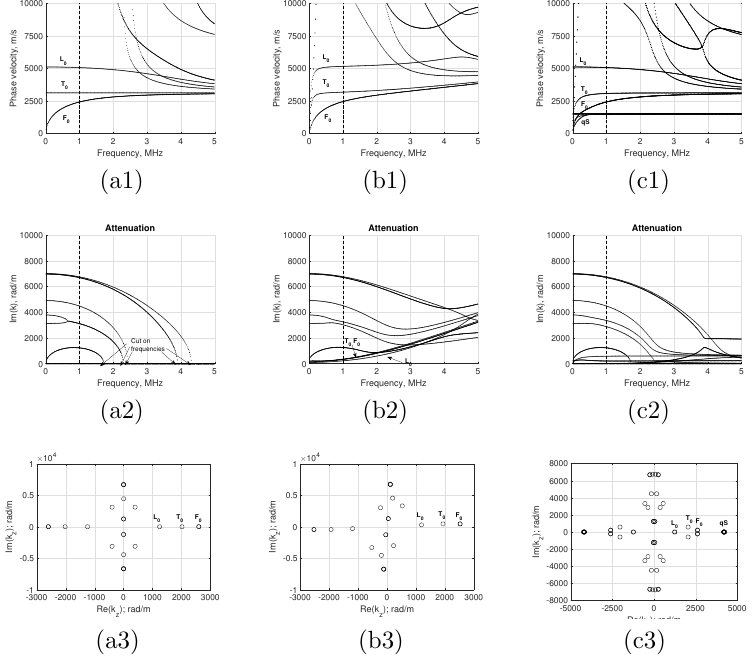
Figure 5. Phase velocity (1), attenuation (2) and wavenumbers (3; at 1 MHz (dashed line)) of waveguide in vacuum (a); with Rayleigh damping a = 1 · 10 6 , b = 3 · 10 − 8 (b); immersed in water